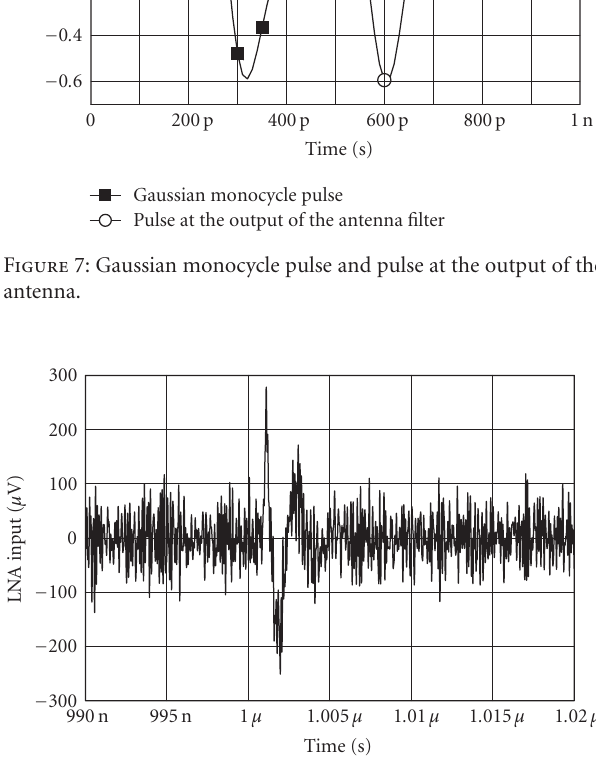
Figure 8: Voltage signal at the input of the LNA, including the noise